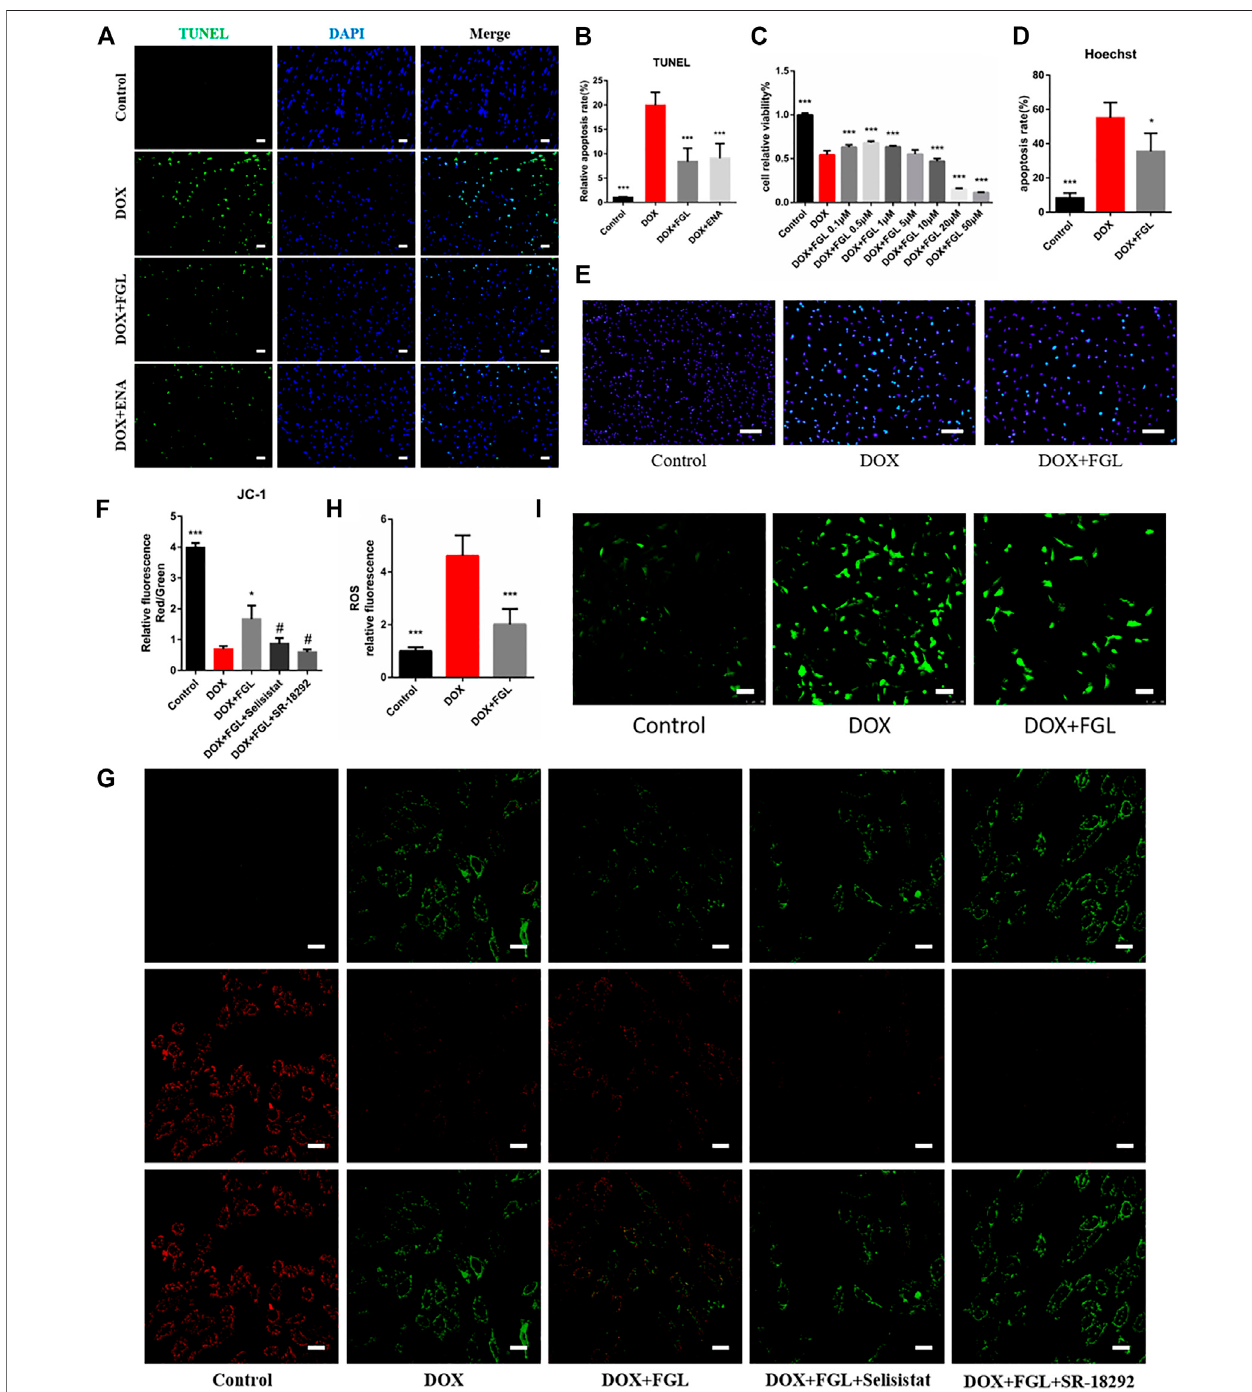
FIGURE 3 | FGL inhibited DOX-induced apoptosis and oxidative injury in vivo and in vitro . (A, B) Representative images and quantitative analysis of apoptosis by TUNEL in the mouse myocardium (n (cid:2) 6). Scale bar: 20 μ m. (C) Effective concentration of FGL in H9C2 cells (n (cid:2) 6). (D, E) Representative images and quantitative analysis of apoptosis by Hoechst staining in H9C2 cells (n (cid:2) 5). Scale bar: 100 μ m. (F, G) Representative images and quantitative analysis of mitochondrial membrane potentialmeasured byJC-1 staininginH9C2 cells (n (cid:2) 3).Scale bar:25 μ m. (H,I) Representativeimages and quantitativeanalysisofROSbyDCFH-DA stainingin H9C2 cells (n (cid:2) 6). Scale bar: 100 μ m * p < 0.05, *** p < 0.001 vs DOX group. # p < 0.05 vs. (DOX + FGL) group.